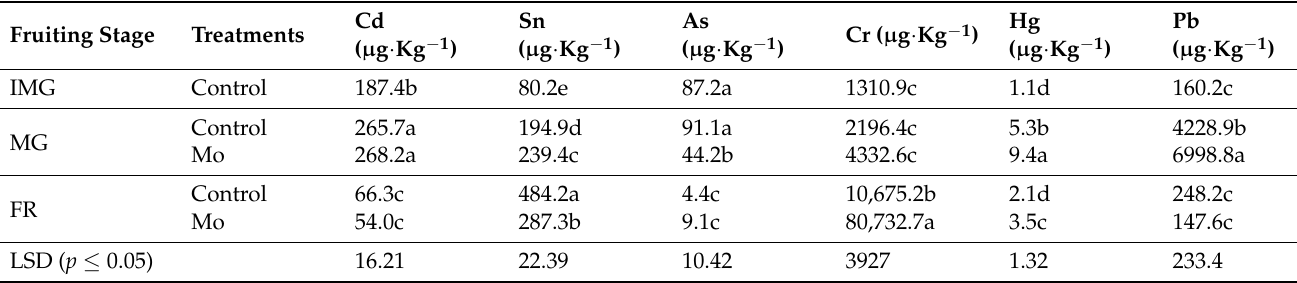
Table 13. Concentrations of heavy metals in loquat seeds affected by the foliar application of molybdenum. Fruiting Stage